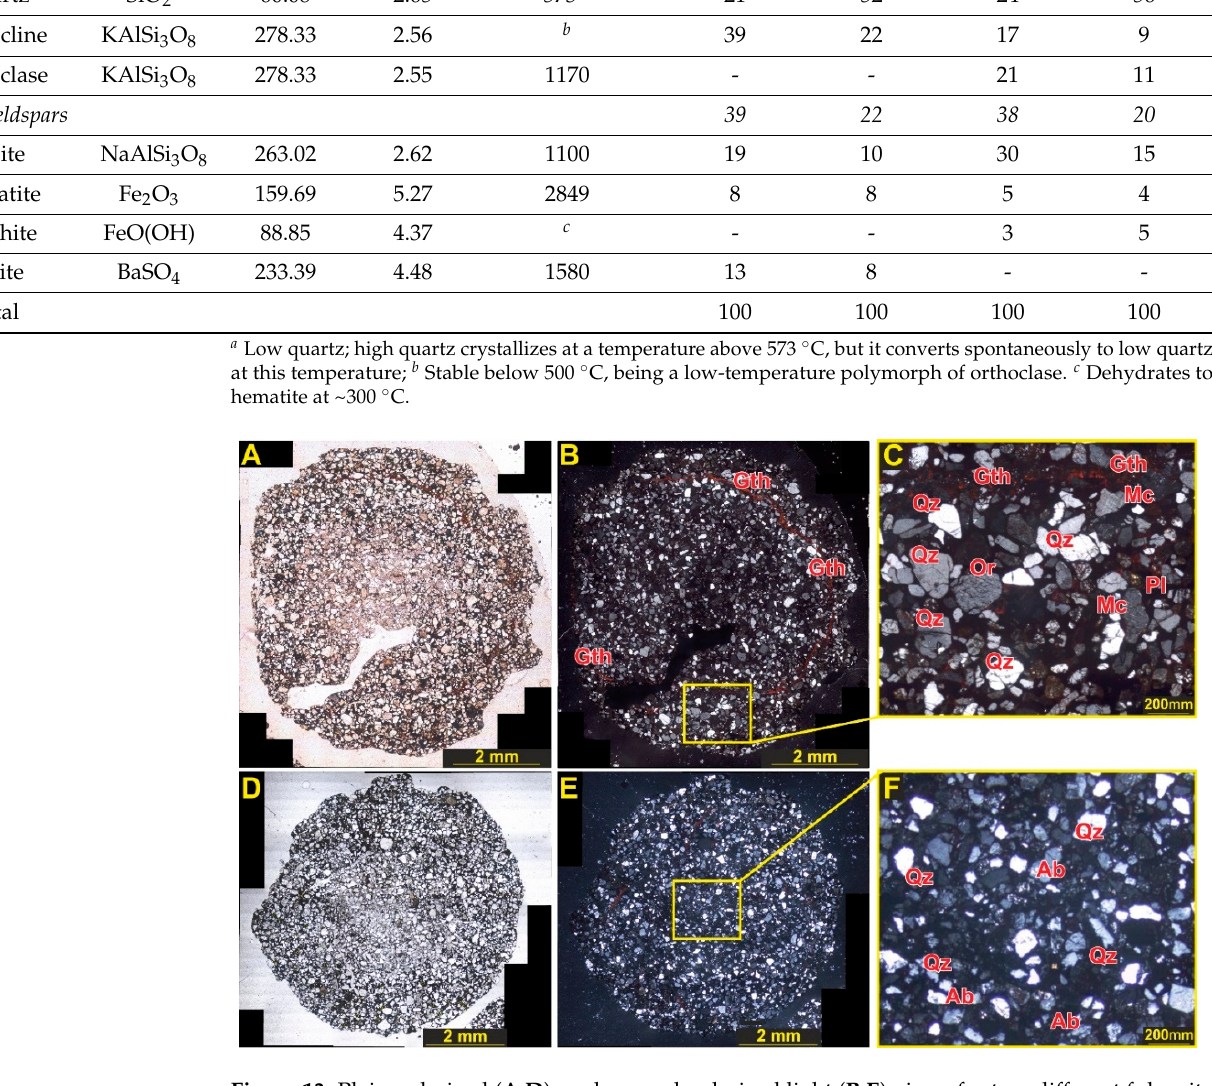
Figure 13. Plain polarized ( A , D ), and crossed polarized light ( B , E ) views for two different fulgurite sections. Quartz, orthoclase, microcline, and plagioclase in fulgurite and Fe oxides in the matrix for the shell ( C ) and core ( F ). Abbreviations: Qz: quartz, Ab: albite, Or: orthoclase, Mc: microcline, Gth: goethite.